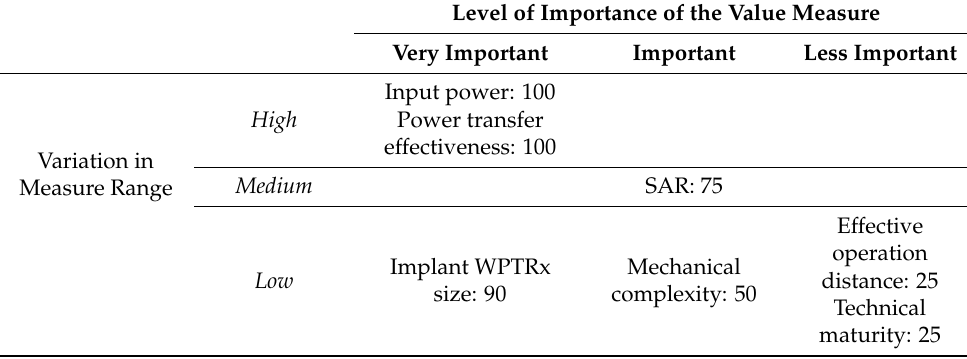
Table 1. Swing matrix of the studied criteria. Weights are assigned based on technical literature values and stakeholders needs.